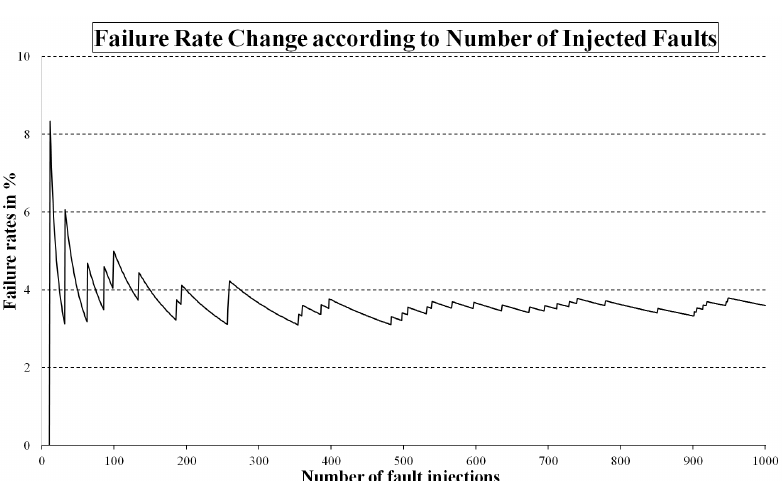
Figure 6. After 300 fault injections, failure rate varies within 1% for a benchmark stringsearch